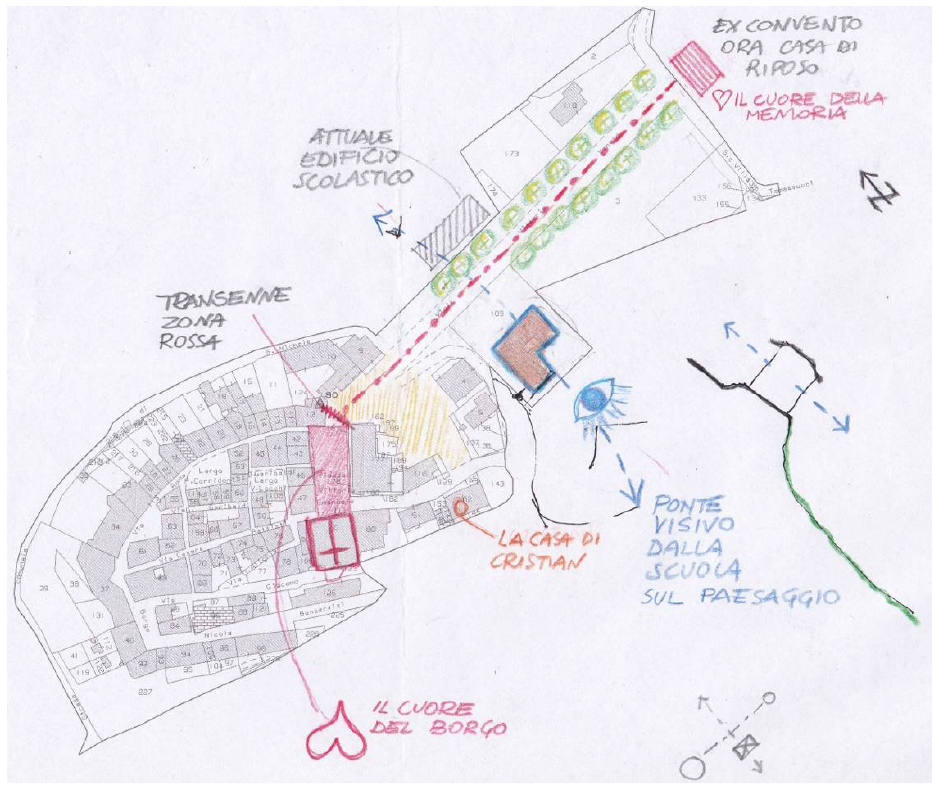
Figure 4. Gualdo, cadastral map. It was shown to draw the children’s attention to the location of the school building (blue) in the urban location and in the landscape of the village (December 2016, recast with notes and remarks during the briefing with children, IP).